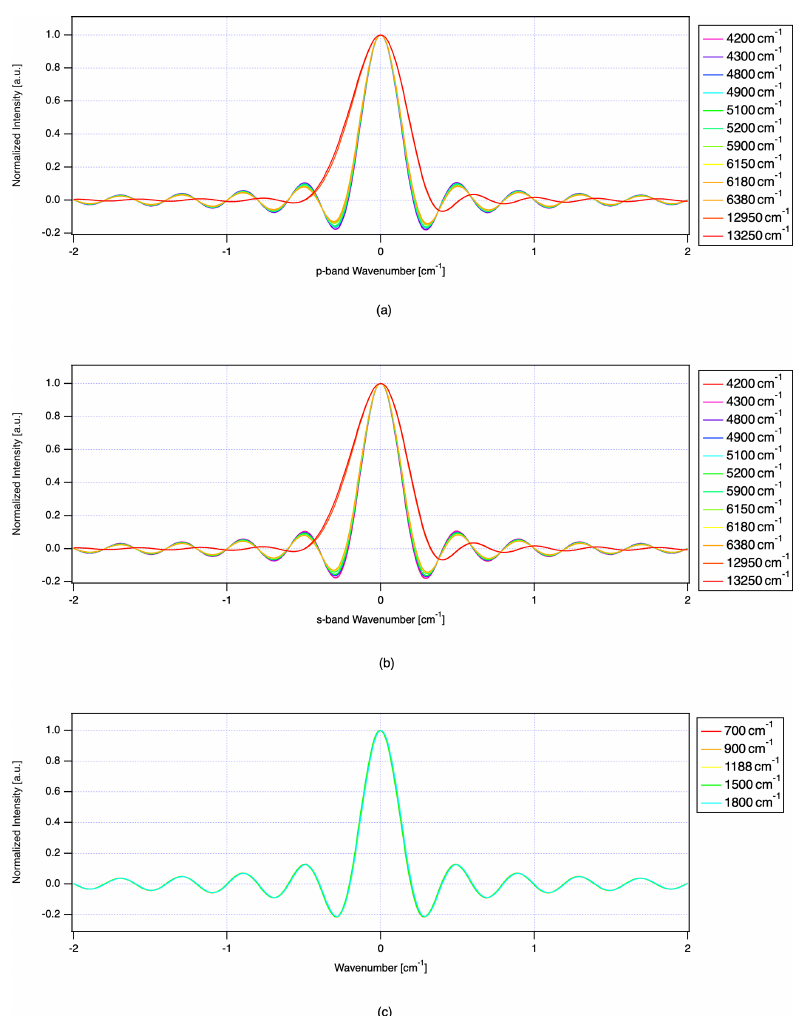
Figure 6. The simulated instrument line shape function (ILS): (a) p -polarization bands for SWIR, (b) s -polarization bands for SWIR, and (c) TIR